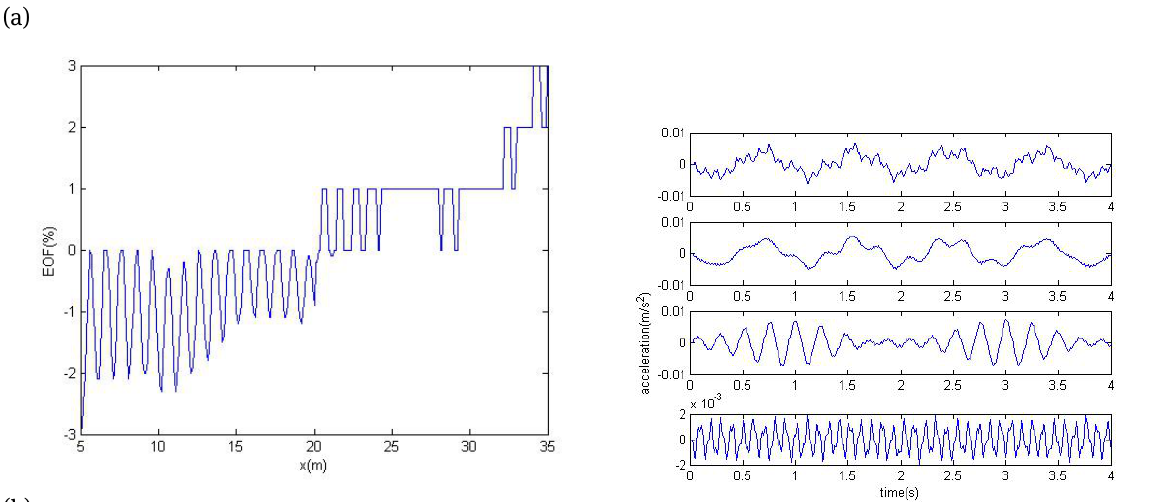
Fig. 5. EOF of the identification results (a) using only one order model (b) using three order model.